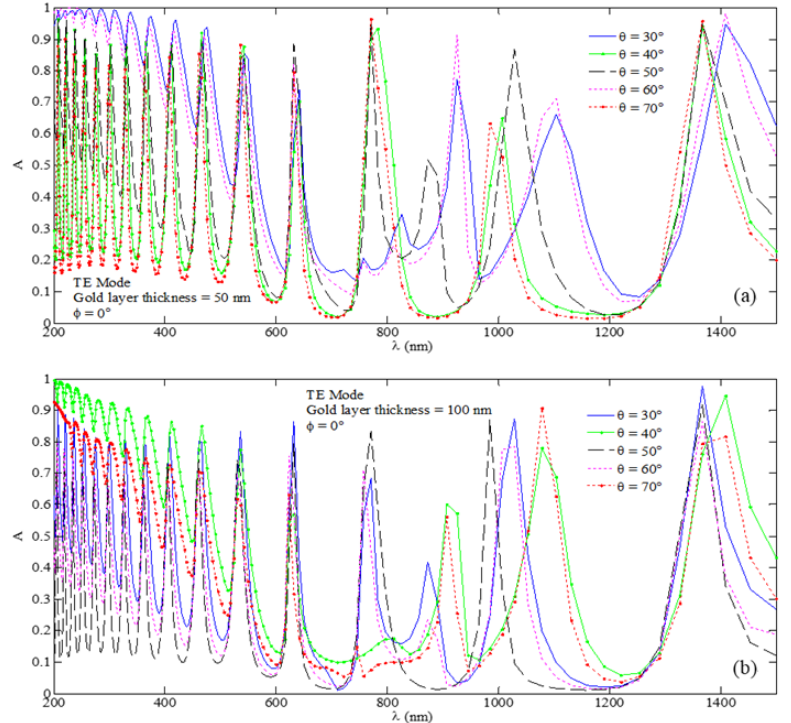
Figure 4. Absorption spectra for the butt-facing U-shaped MPA nanostructure under the TE wave excitation with ϕ = 0° incidence and corresponding to the cases of ( a ) 𝑑 = 50 nm and ( b ) 𝑑 = 100 nm excitation with φ “ 0 ˝ incidence and corresponding to the cases of ( a ) d “ 50 nm and ( b ) d “ 100 nm with 𝑡 = 500 nm. with t “ 500